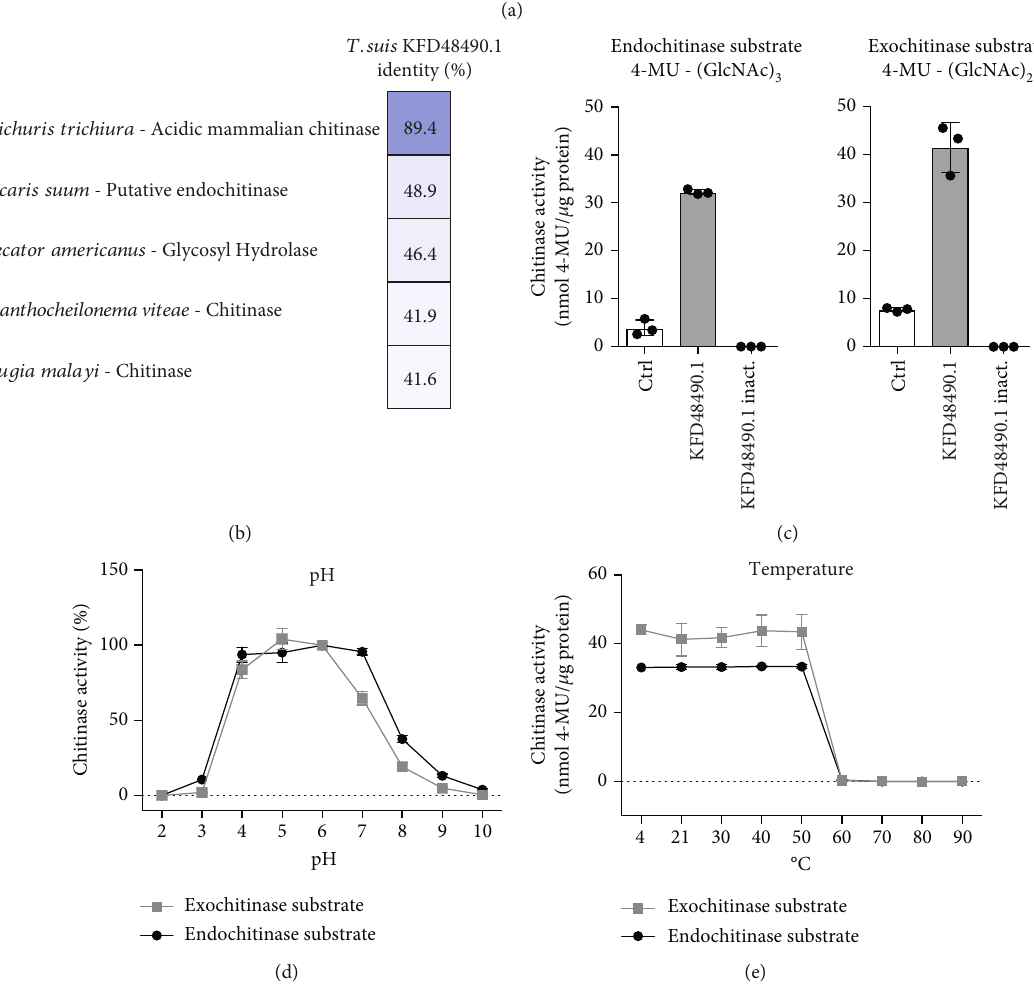
Figure 2: KFD48490.1 is an active chitinase. (a) KFD48490.1 amino acid sequence with mapped signal peptide (red), catalytically active residues (highlighted in blue and red), and the chitin-binding domain (black, italic). (b) Amino acid sequence alignment of KFD48490.1 and known nematode chitinases. (c) Fluorimetric chitinase assay testing recombinant KFD48490.1, heat-inactivated KFD48490.1, and a chitinase control enzyme (ctrl) with substrates for endochitinase (left) and exochitinase (right) activity. Data shown are mean ± SD of n = 3 replicates from one of three independent experiments. (d) Chitinase assay testing KFD48490.1 activity depending on pH (range 2- 10). (e) Chitinase assay testing KFD48490.1 preincubated at di ff erent temperatures (4 – 90 ° C) for 1h prior to the assay. Data shown are mean ± SD of n = 3